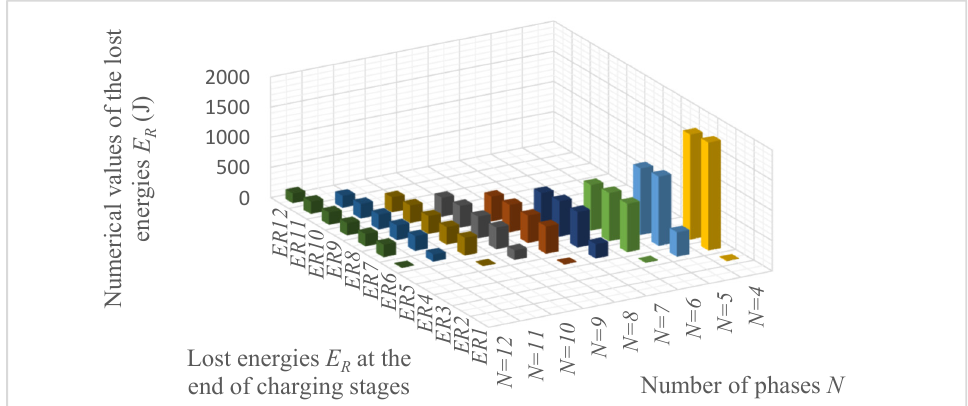
Figure 16. Amounts of energy lost during the charging of the SC circuit during the operations of the individual duty cycles at different numbers of phases.